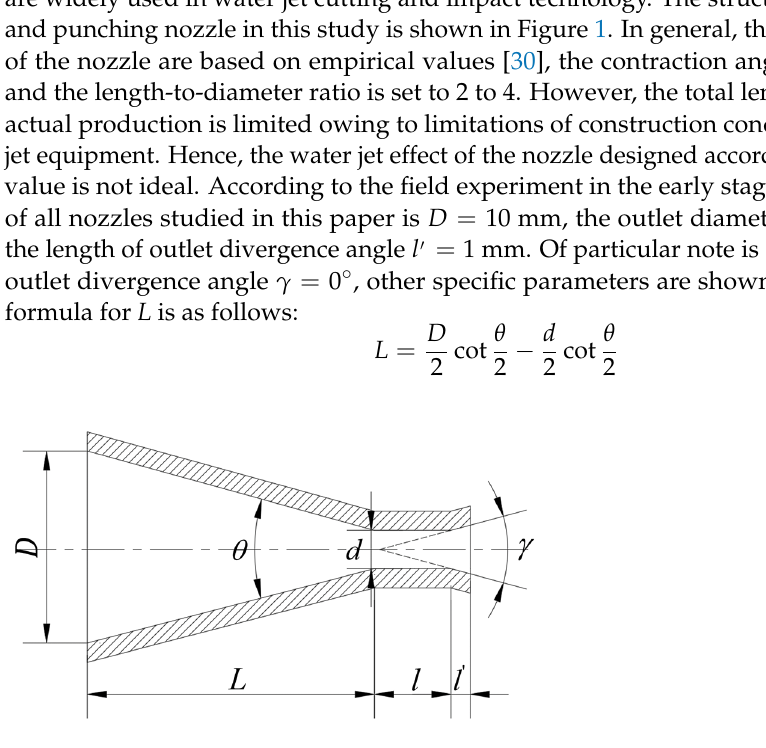
Figure 1. Diagram of the coal breaking and punching nozzle structure.